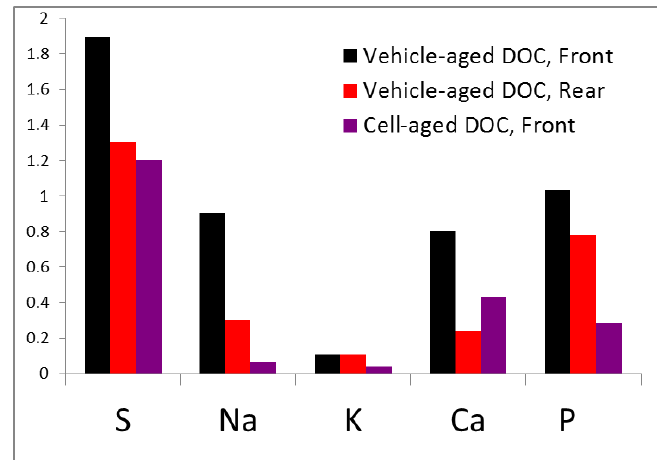
Figure 2. Loading of trace elements in samples taken from the vehicle-aged catalyst (front and rear), as well as in the sample taken from the catalyst aged in an engine cell, as determined by X-ray fluorescence (XRF).